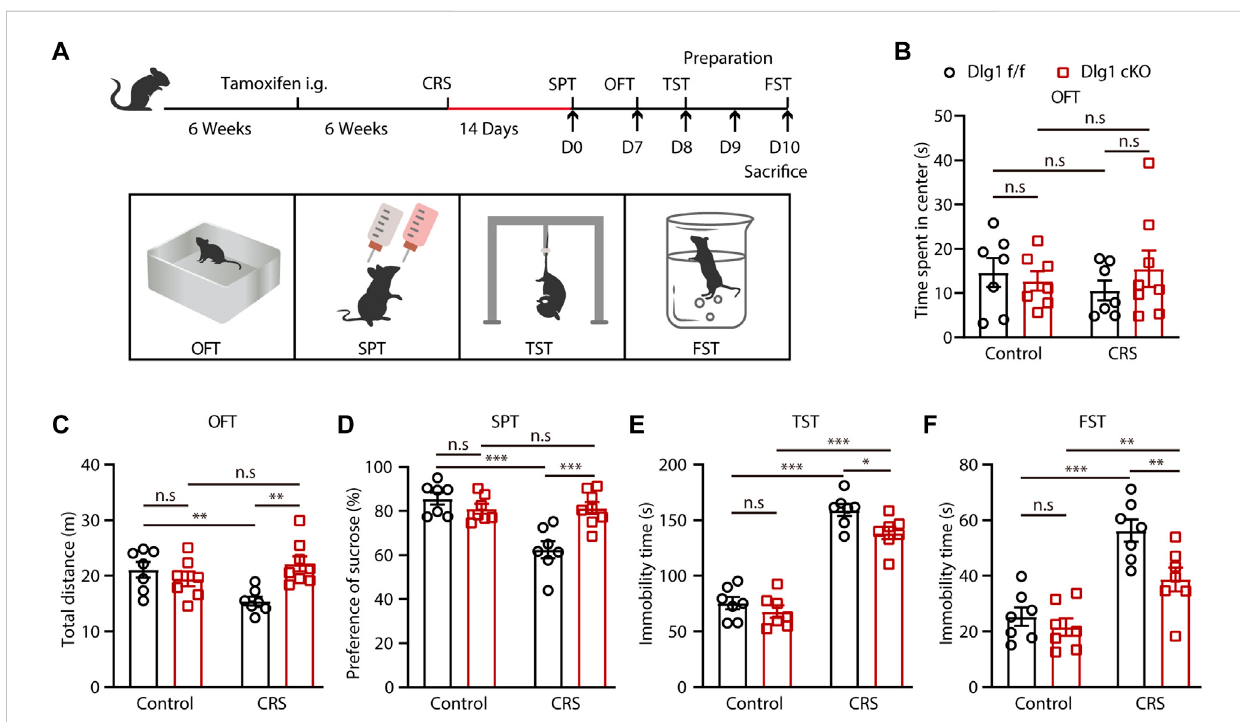
FIGURE 1 Microglial Dlg1 knockout alleviates CRS-induced depression-like behavior in mice. (A) The scheme of tamoxifen administration, stress stimuli and behavioral tests. (B – C) Travel-time spent in the central area and total travel-distance in the OFT of Dlg1 f/f and Dlg1 cKO mice with and without CRS exposure. (D) Sucrosepreferenceof Dlg1 f/fand Dlg1 cKOmicewithandwithoutCRSexposure. (E – F) Immobilitytimeof Dlg1 f/fand Dlg1 cKOmicewith and without CRS exposure in the TST and FST. Data are presented as the mean ± SEM; * p < 0.05; ** p < 0.01, *** p < 0.001, two-way ANOVA with Turkey ’ s multiple comparisons